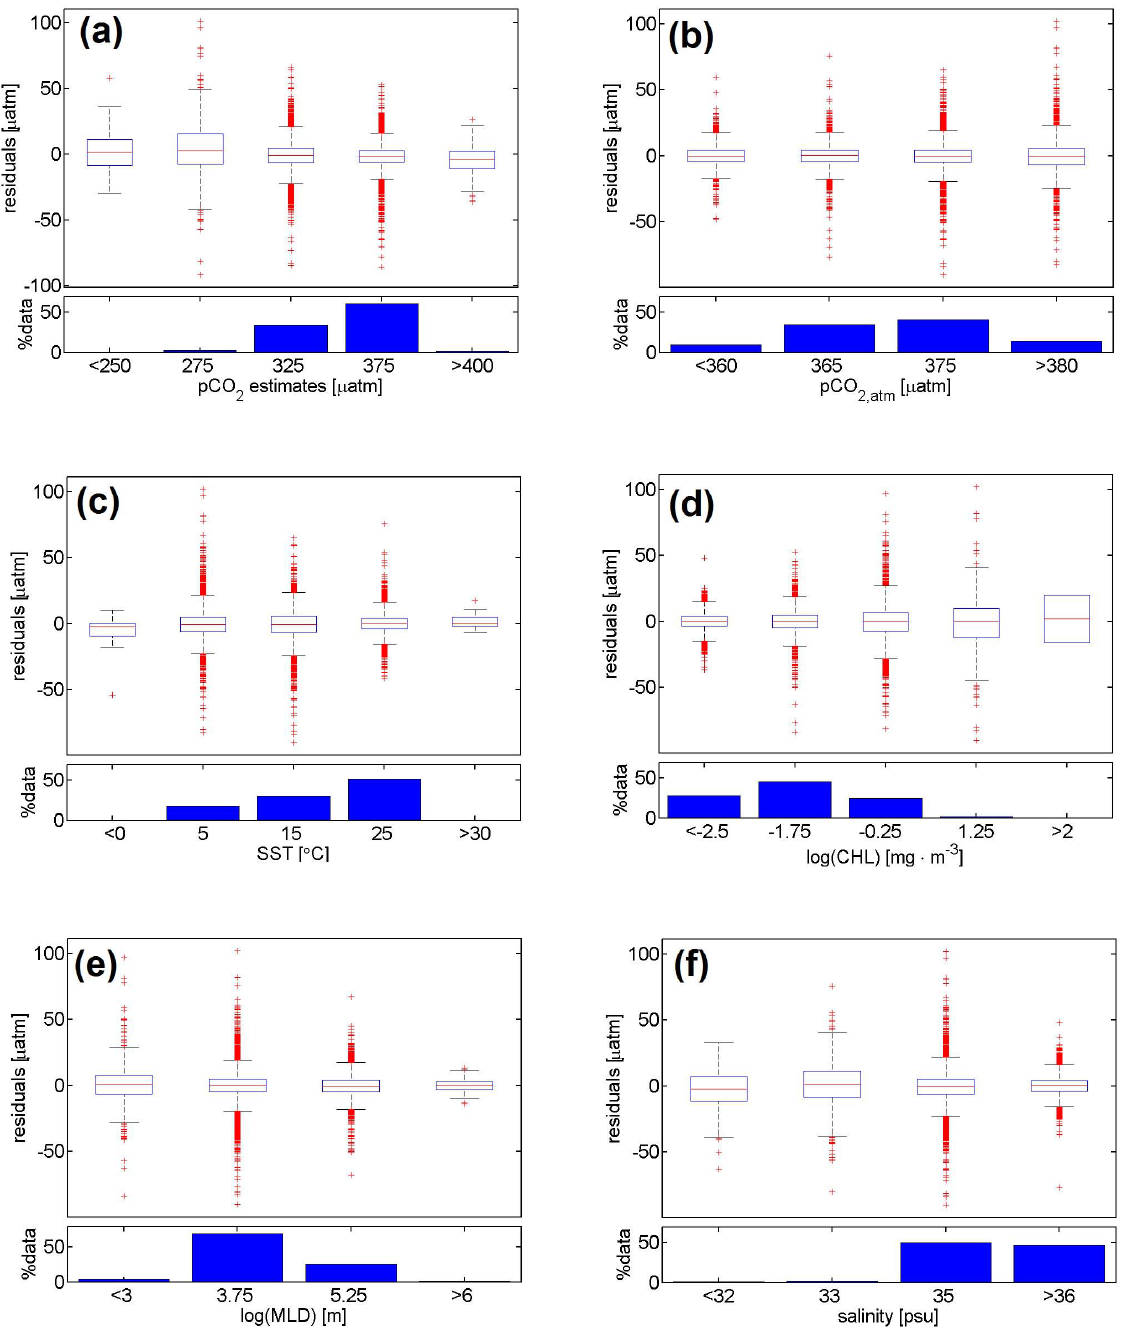
Fig. 3. Residuals as a function of (a) fitted p CO 2 , (b) atmospheric p CO 2 , (c) sea surface temperature (SST,) (d) natural log of surface chlorophyll (log(CHL)), (e) natural log of mixed layer depth (log(MLD)), and (f) sea surface salinity (SSS). The upper plot in each panel depicts the residuals, shown as a box-and-whiskers plot. The red line in the box show the median, the blue box indicates the 25 and 75 percentiles and red crosses mark residuals outside this interval. The lower plot shows the relative number of observations within each